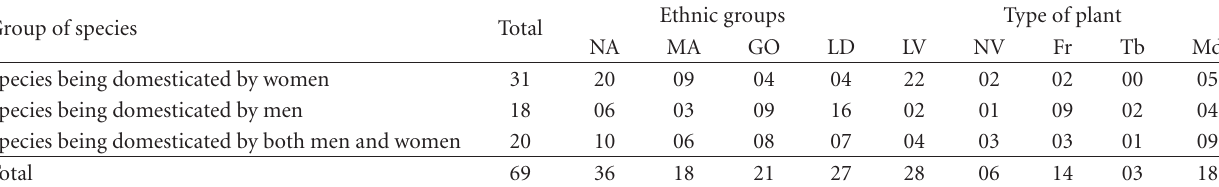
Table 6: Classification of the species under domestication according to the gender and to their specific utilization. Group of species